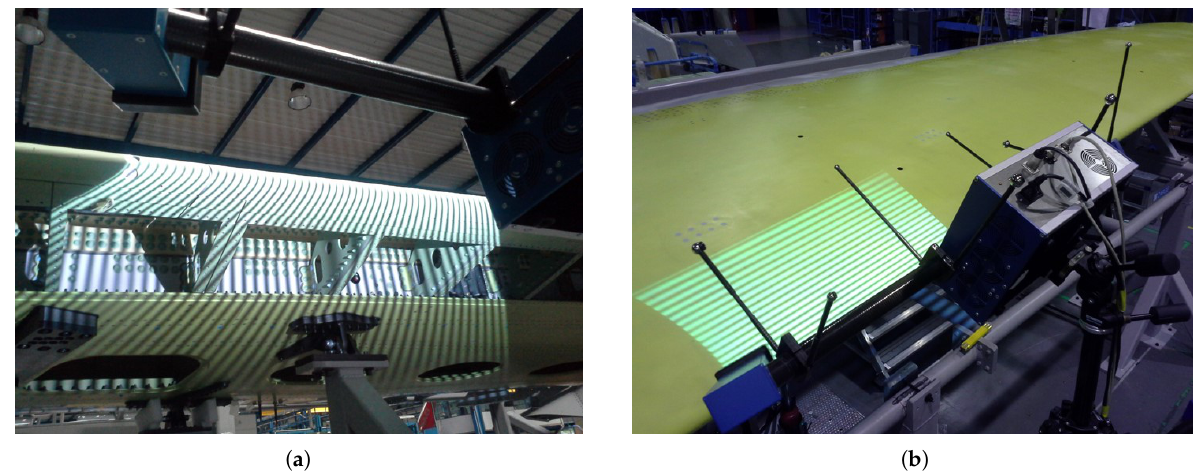
Figure 10. Fringe Projection measurements on wings. ( a ) Measurement of the BLADE GKN wing. Aerospace wing (front nose section and lower cover). Due to the size of the measuring field, the strongly curved front nose section, the subsequent geometry of the wing and recordings under daylight, we show here an example of an extreme measuring situation for the FP-technology. ( b ) Measurement of the BLADE Saab wing (front nose section and upper cover). The setup is equipped with retro-reflectors mounted on CFRP sticks for interacting with the laser tracker system. Reprinted with permission from Reference